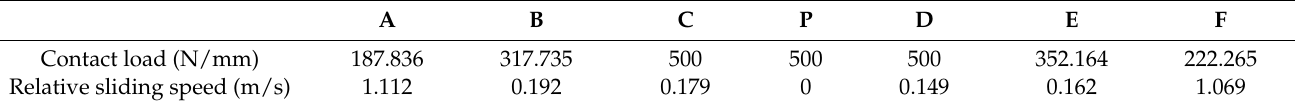
Table 4. The load and relative sliding speed at each key point.